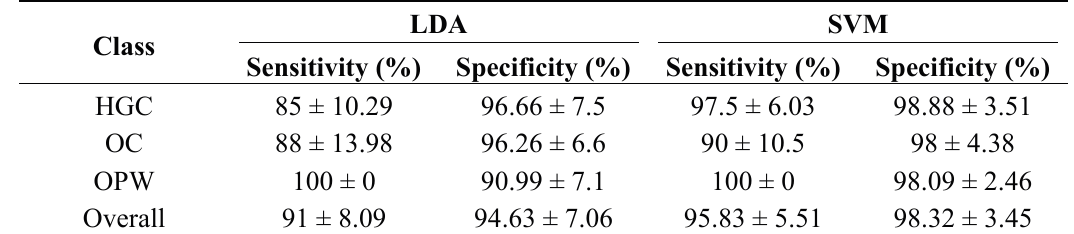
Table 2. Sensitivity and specificity for growing conditions classification after cross-validation